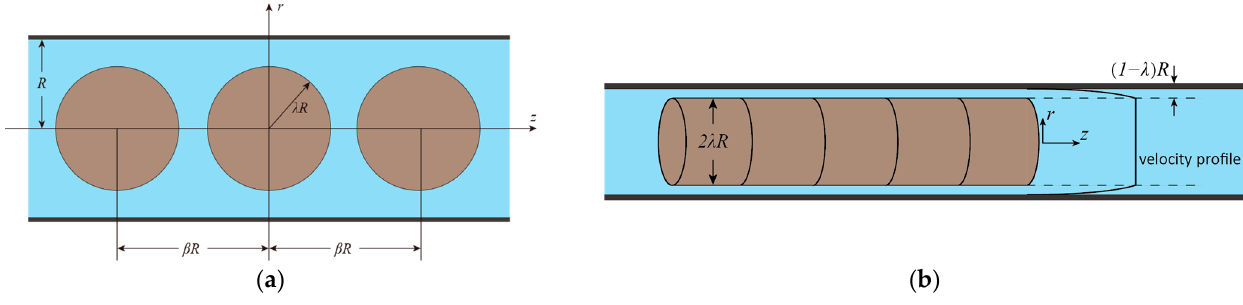
Figure 1. Schematic view of dispersed droplets with intermediate size in single capillary tube. ( a ) Dispersed droplets are located on the axis of the cylinder and equally spaced; ( b ) the simplified “stacked coins” model.